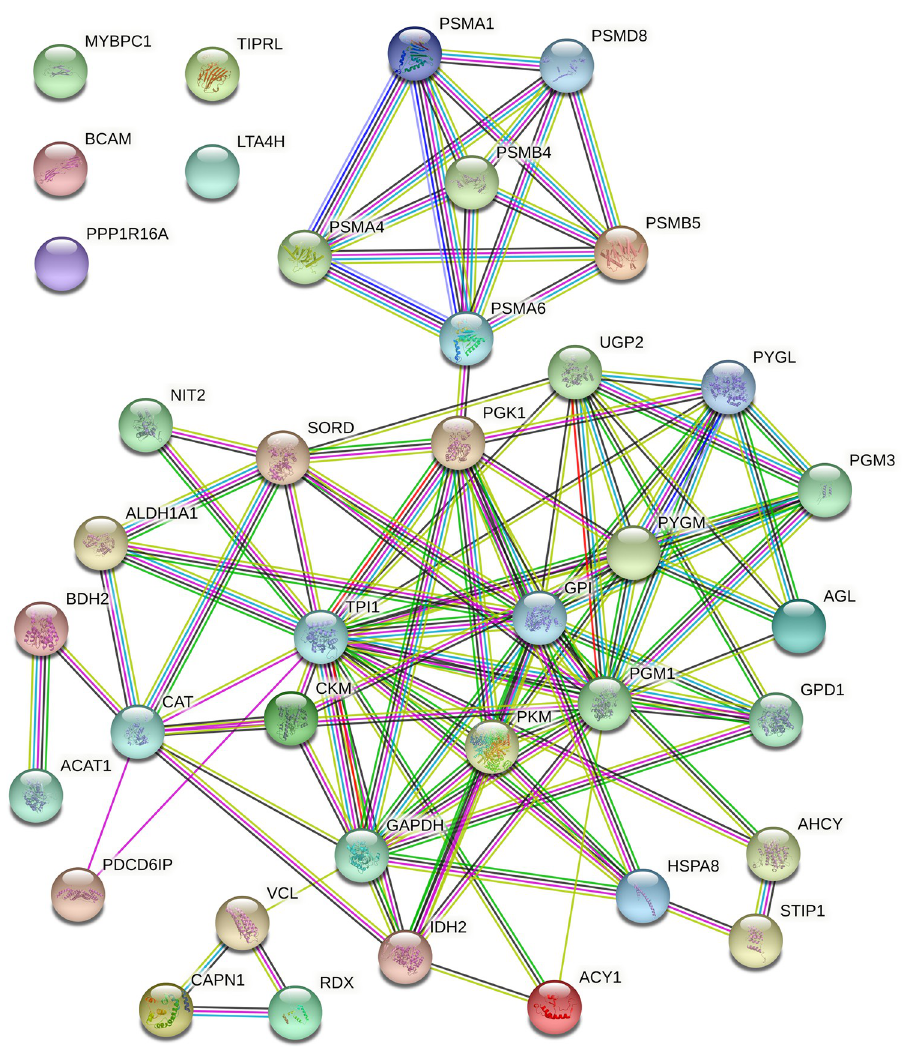
Fig 3. Protein-protein interaction map of the 36 proteins differentially expressed up-regulated in the stressed pigs. Interactions are based on STRING v.11.0 software analysing the identified proteins against Sus scrofa database. Interactions are shown in different colors: cyan is from curated databases, magenta is experimentally determined, dark green is gene neighbourhood, red is gene fusion, blue is gene co-occurrence, light green is textmining, black is co- expression and light blue is protein